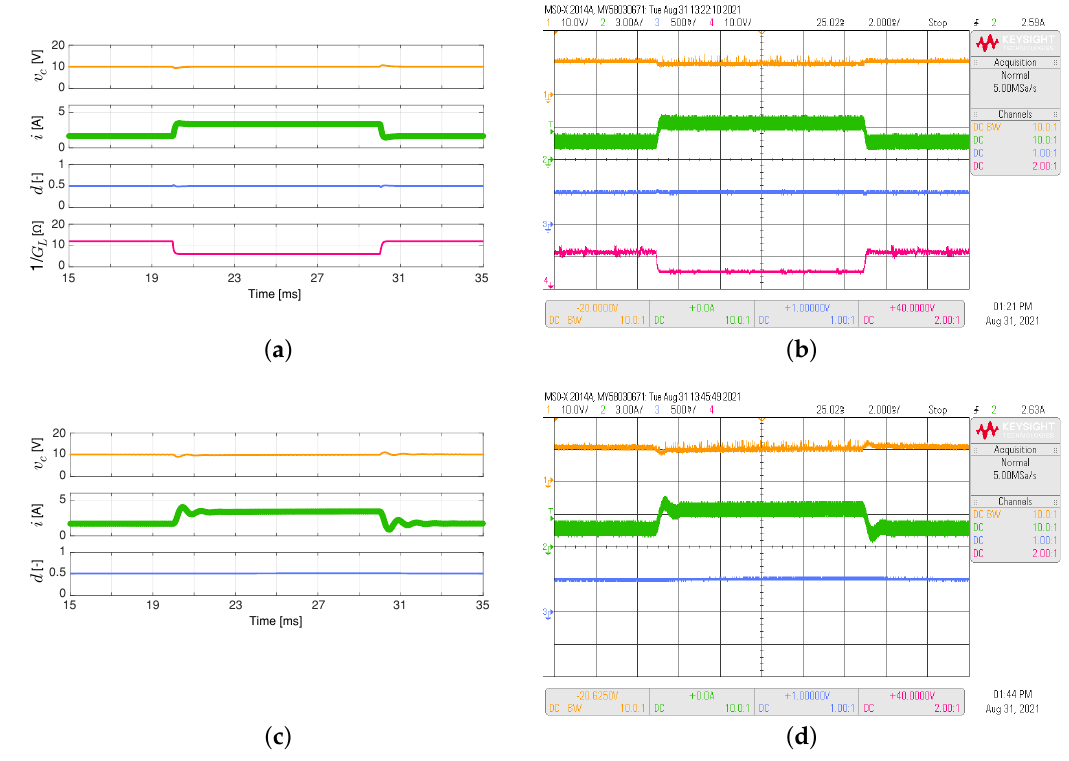
Figure 7. Simulated ( a , c ) and experimental ( b , d ) dynamic responses of the non-inverting buck-boost converter when the load resistance is a 50 Hz square waveform between 6 Ω and 12 Ω , and a duty cycle of 0.5: ( a , b ) adaptive PI-PBC controller, ( c , d ) PI controller. CH1: v c (10 V/div), CH2: i (3 A/div), CH3: d (500 mV/div), CH4: 1/ G L ( 10 V/div) (it is calculated only by the PI-PBC controller), and time base of